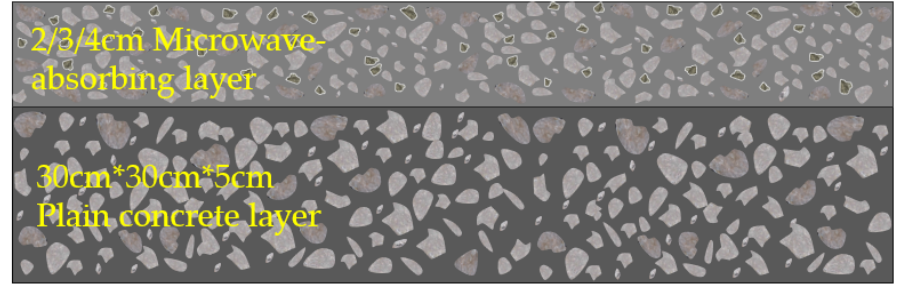
Figure 3. Schematic diagram of double-layer microwave-absorbing thin-layer concrete specimen.